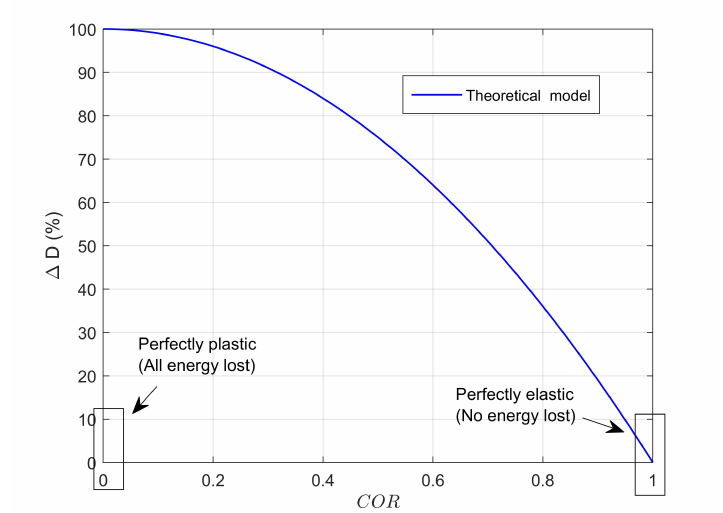
Figure 11. Description of impact kinematics: Theoretical % ∆ D − COR